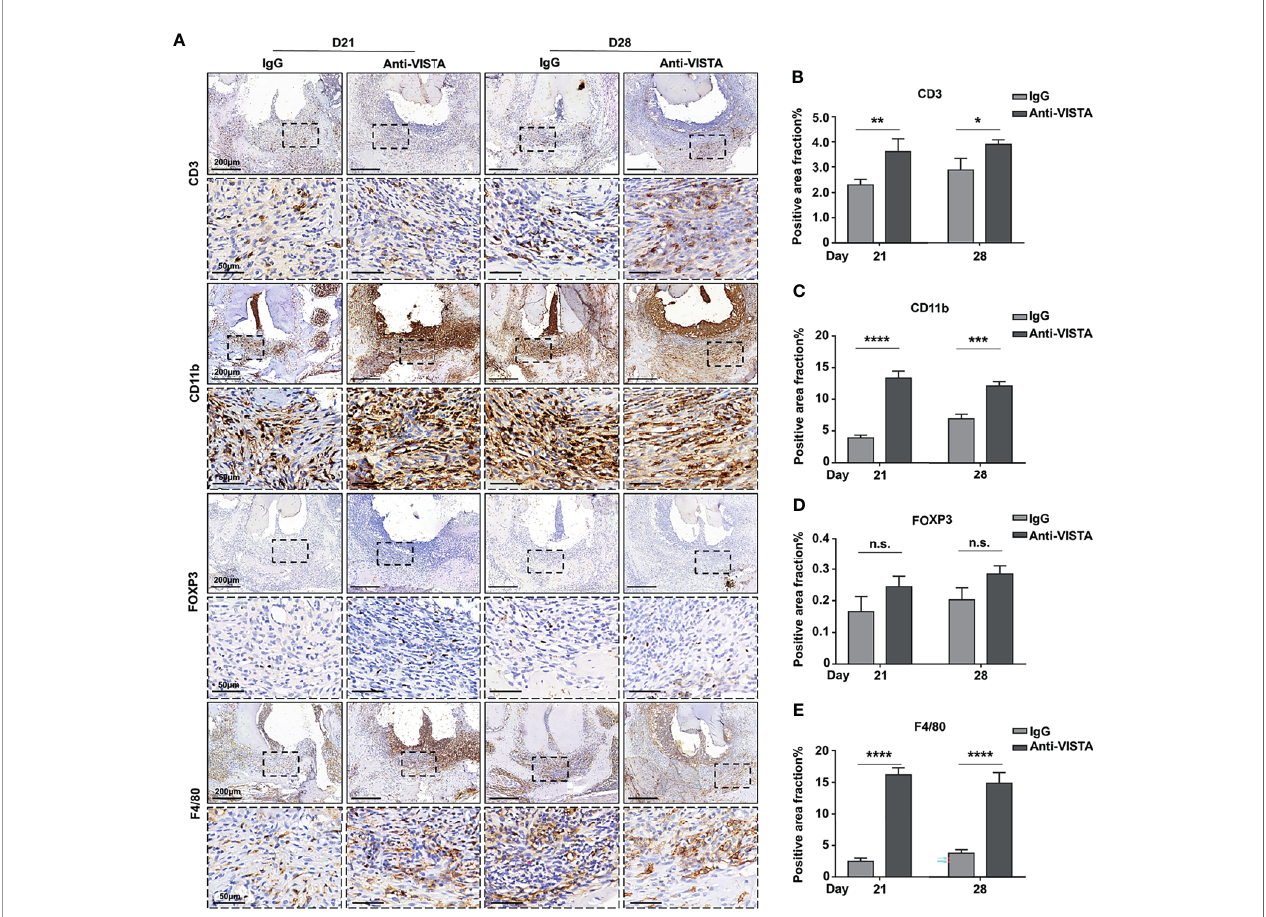
FIGURE 5 | Blockade of VISTA enhanced immune cell in fi ltration in tissues of mouse experimental apical periodontitis. (A) The accumulation of CD3-, FOXP3-, CD11b-, and F4/80-positive cells in the anti-VISTA-treated or IgG-treated group at different time points in mouse experimental apical periodontitis tissues (n=5). Quantitative analysis of (B) CD3, (C) CD11b, (D) FOXP3, and (E) F4/80-positive cells. Scale bars =200 m m or 50 m m at different magni fi cations, as shown in the images. n.s., not signi fi cant. *p < 0.05, **p < 0.01, ***p < 0.001, ****p <